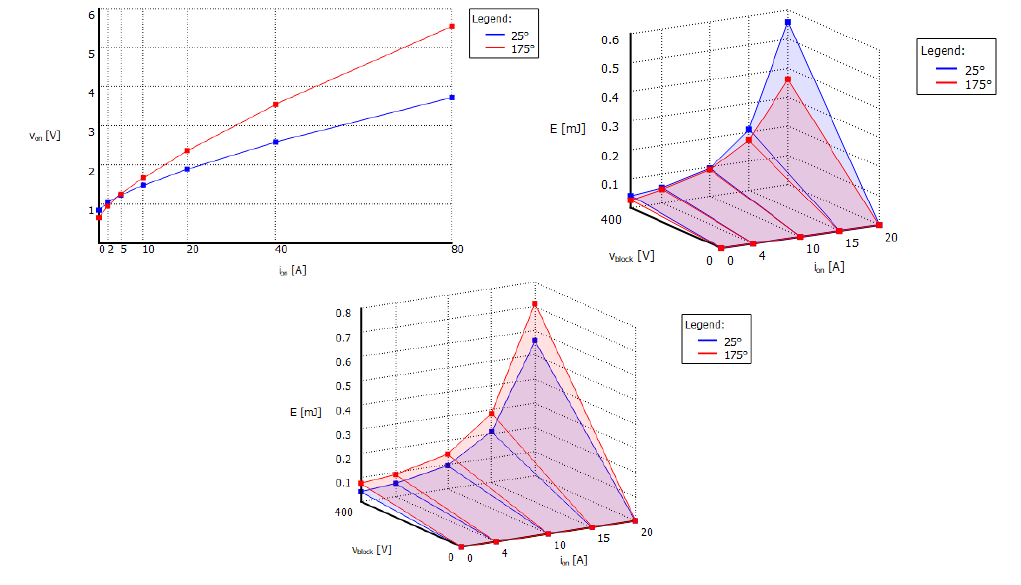
Figure 6. IGBT thermal loss description conduction, turn-on and turn-off losses.